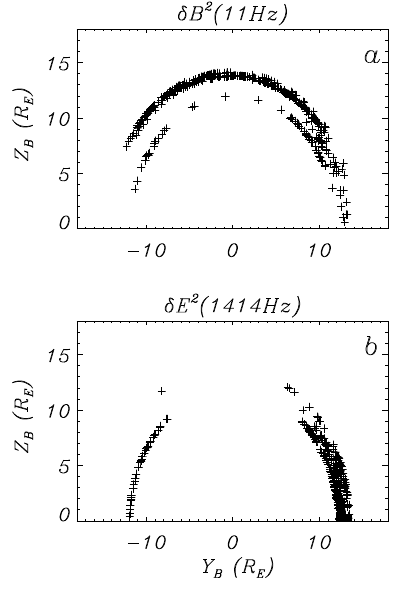
Figure7:Theplane( Y B ,Z B )isthe( Y GSE ,Z GSE )planerotatedaround X GSE so